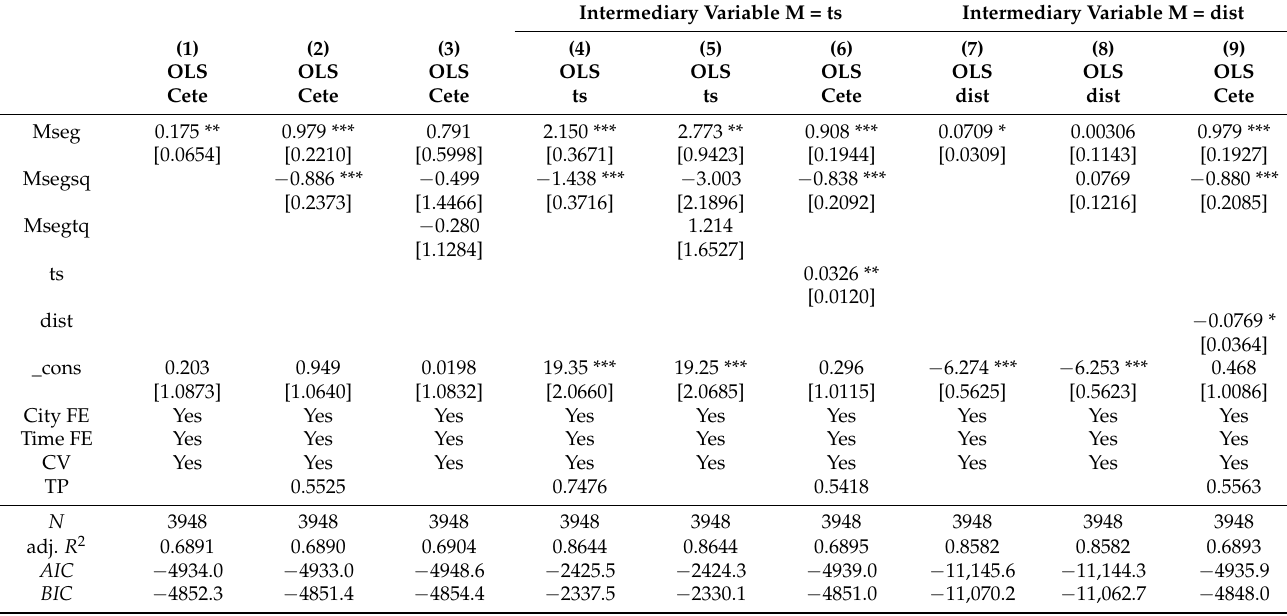
Table 4. Regression results of the baseline and mediated effects